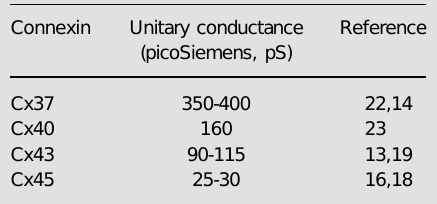
Table 1 - Unitary conductance of the four connexin types found in the vascular